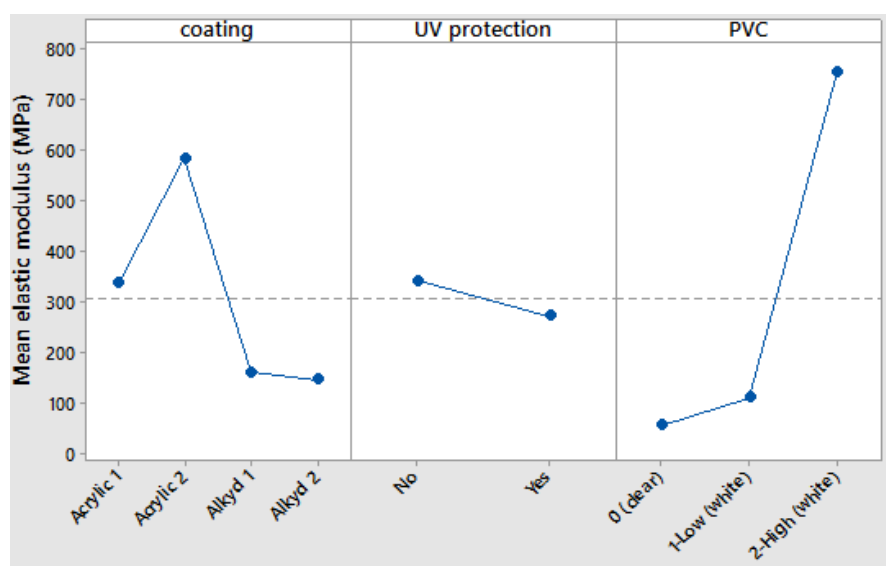
Figure 8. Main effects plot for the mean elastic modulus (room temperature).